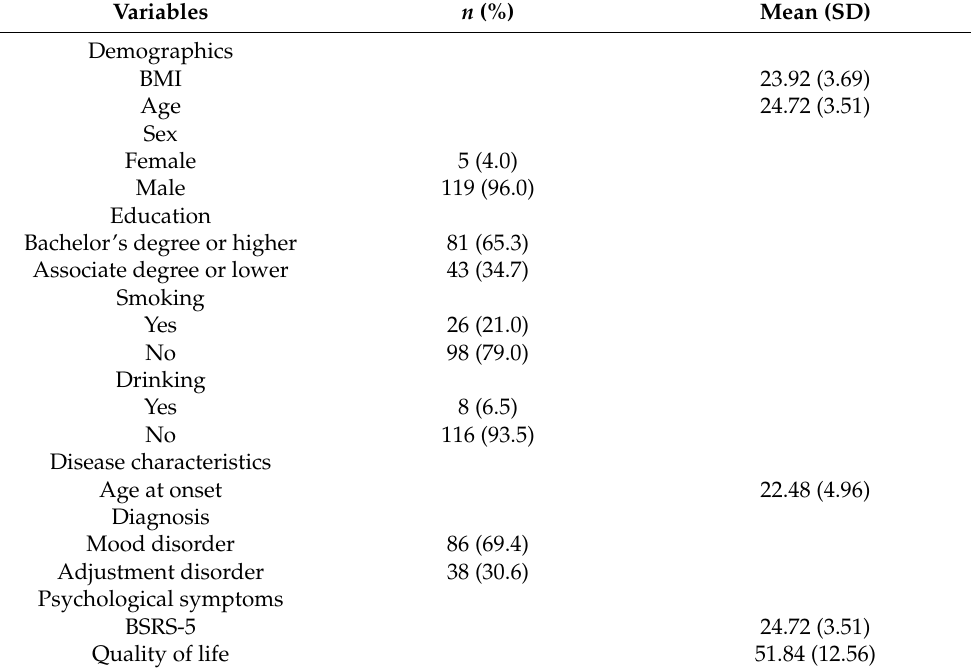
Table 1. Demographic characteristics, disease characteristics, and psychological symptoms of the study population ( n = 124).